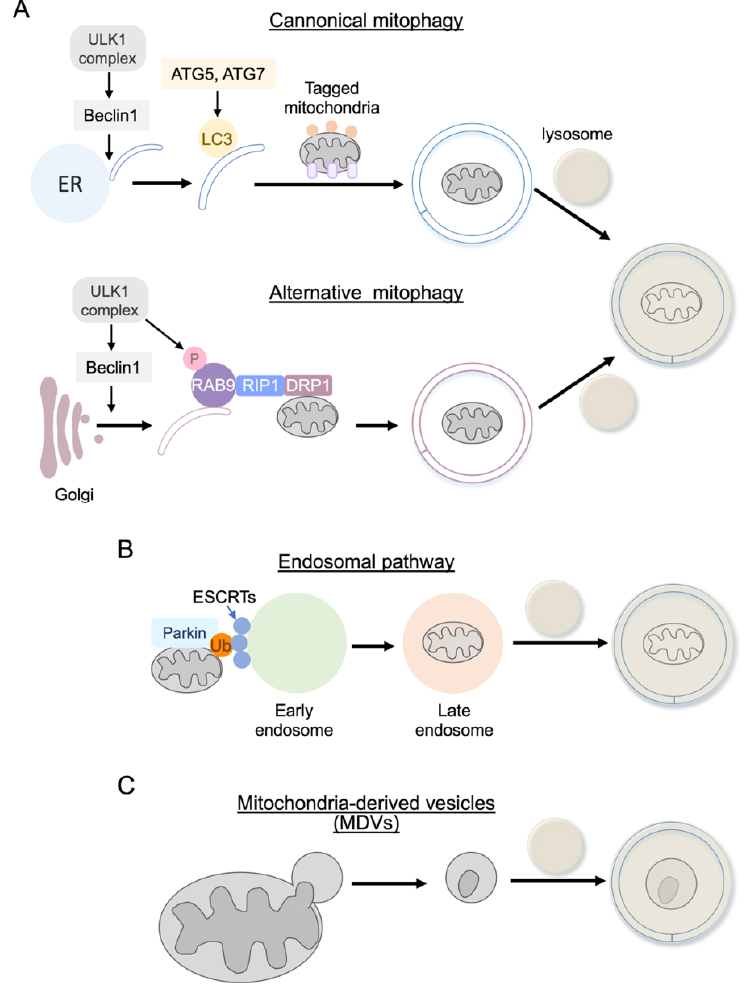
Figure 5. Alternative (non-canonical) autophagy. ( A ) Rab9-dependent mitophagy is not dependent on ATG5/ATG7 and LC3, which are required for canonical autophagy, including PINK1/Parkin- mediated mitophagy. Rab9-dependent autophagy is mediated by ULK1, Rab9, Rip1, and dynamin- related protein 1 (Drp1) in the heart. ( B ) Endosomal pathway. Mitochondria ubiquitinated by Parkin are also eliminated by the endosome pathway. A ubiquitinated mitochondrion is captured by ESCRT complexes on the Rab5 positive early endosome and, after its maturation, the endosome fuses with the lysosome for degradation. ( C ) Mitochondrial-derived vesicles (MDVs). Mitochondria labeled by the PINK1/Parkin pathway are also subjected to MDVs-dependent